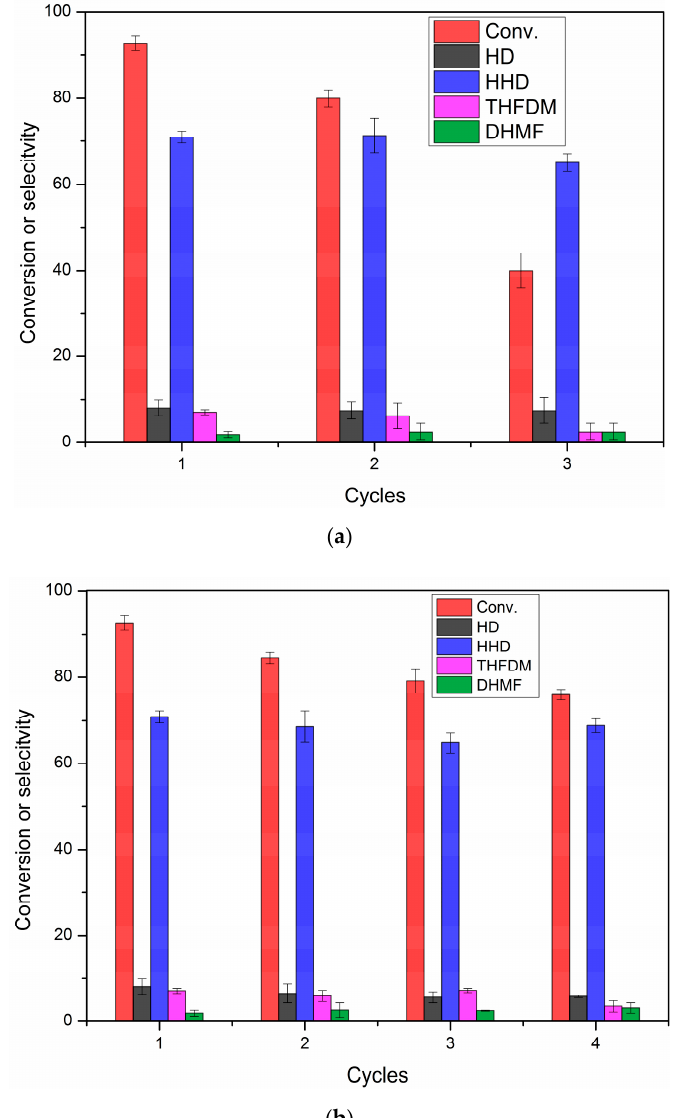
Figure 4. Reuse experiment for the hydrogenation of HMF to HHD with different recycling method, washed by H 2 O/C 2 H 5 OH ( a ), further washed in hot tetrahydrofuran ( b ). Reaction conditions: